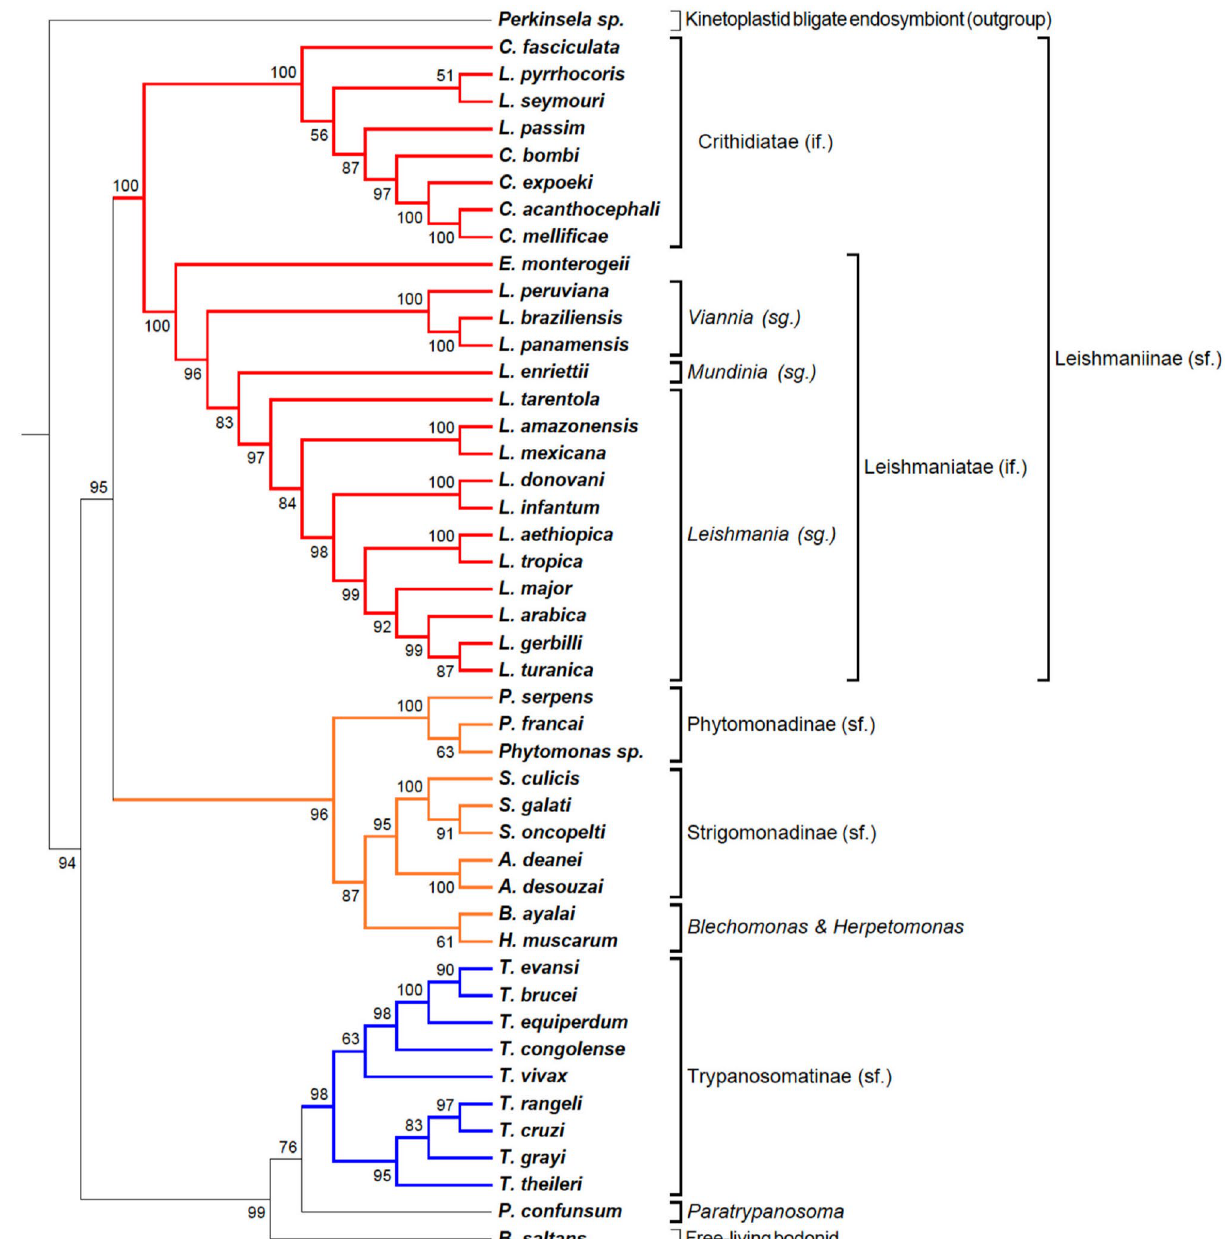
Figure 2. Phylogenomic tree of Kinetoplastid protozoa. Phylogram constructed with the TOMM approach using approximately 5636 orthologous protein pairs across 46 Kinetoplastida species with genome sequence available (Table 1 and Supplemental Table S1). Numbers next to the branches represent the percentages of approximate unbiased support probabilities for 10,000 bootstraps, calculated using the pvclust package 82 in R (R Core Team. R: A language and environment for statistical computing. R Foundation for Statistical Computing, Vienna, Austria, 2018, URL: https ://www.R-proje ct.org/). The Newick file was annotated using the program MEGA 6. Abbreviations: if (infra family); sg (subgenus); sf